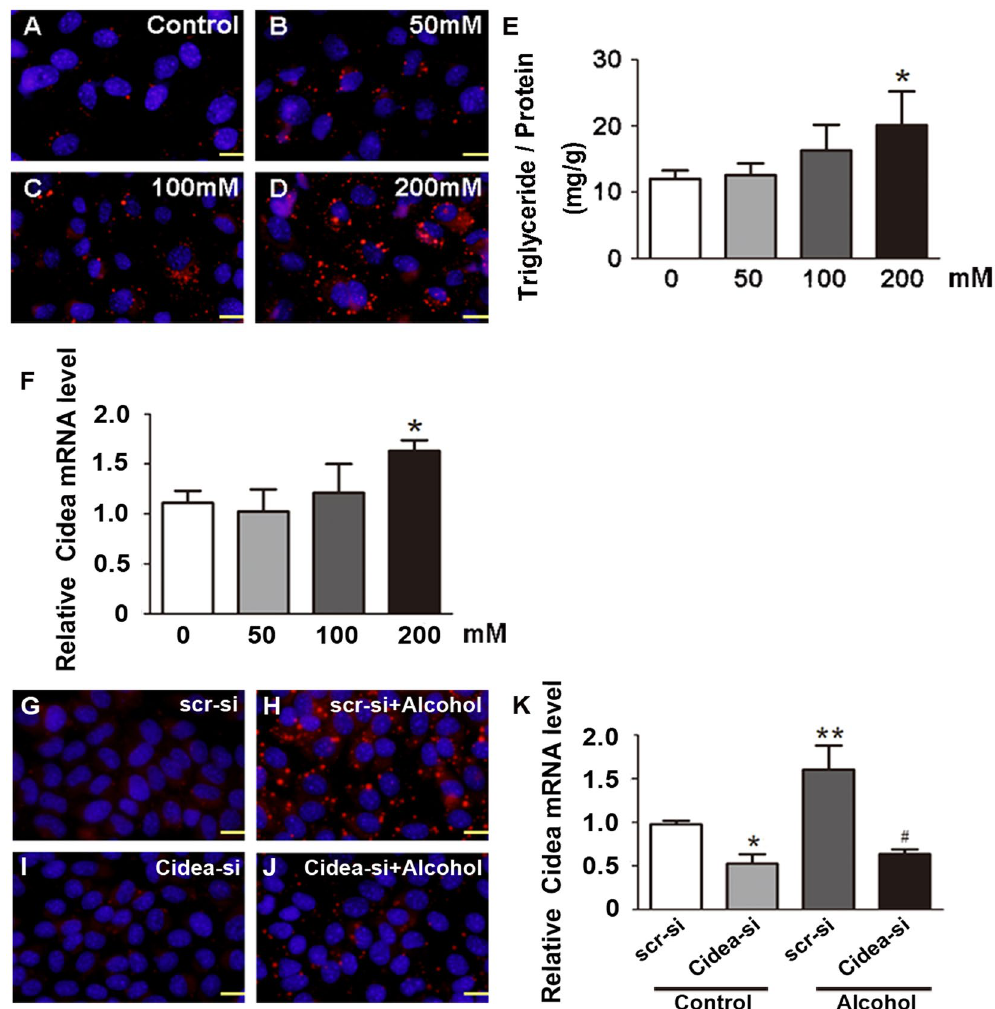
Figure 2. Knockdown of Cidea reduces triglyceride accumulation in alcohol-exposed cells. AML12 cells were incubated with various concentrations of alcohol for 48 hours. ( A – D ) Evaluation of Nile red staining (X200). The triglyceride contents ( E ) and ( F ) the Cidea mRNA levels in AML12 cells. Means ± SD, n = 3, * p < 0.05 vs. control group. ( G – J ) Evaluation of Nile red staining (X200) and ( K ) the Cidea mRNA levels in AML12 cells with or without Cidea knockdown by small interfering RNA (siRNA) in the presence or absence of 200 mM alcohol. Means ± SD, n = 3, * p < 0.05; ** p < 0.01 vs. scr-si group; # P < 0.05 vs. scr-si + Alcohol group. Scr-si, scrambled siRNA; Cidea-si, Cidea